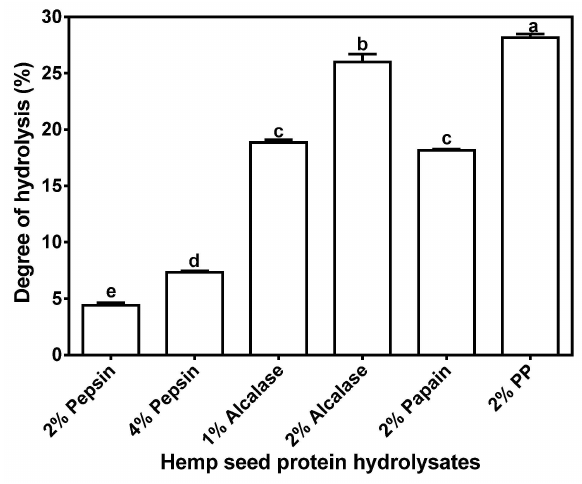
Figure 1. Degree of hydrolysis of different enzymatic hemp protein